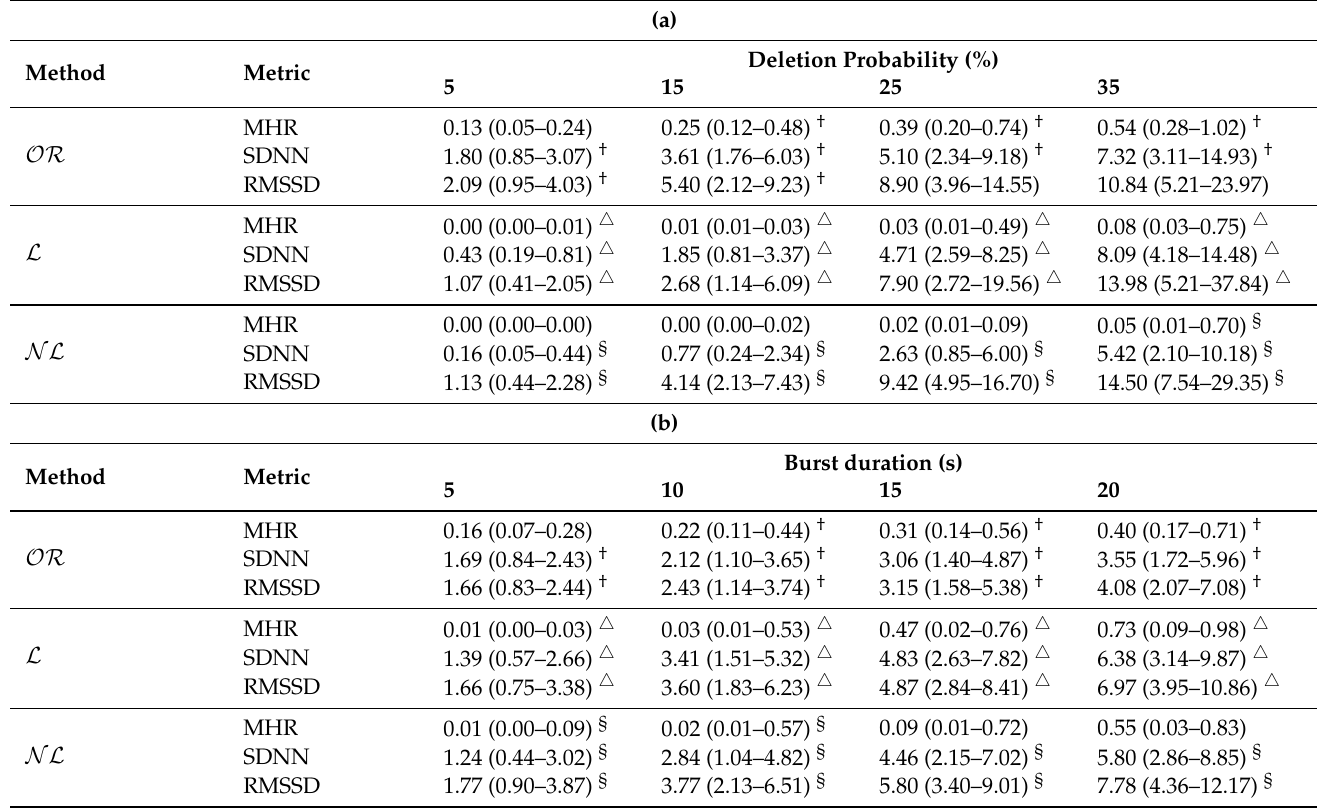
Table 1. Relative error (%) of time-domain metrics. (a) Scattered missing beats. (b) Bursts. †: Signif- icant differences ( p < 0.05) between OR and L . (cid:52) : Significant differences ( p < 0.05) between L and N L . §: Significant differences ( p < 0.05) between N L and OR .